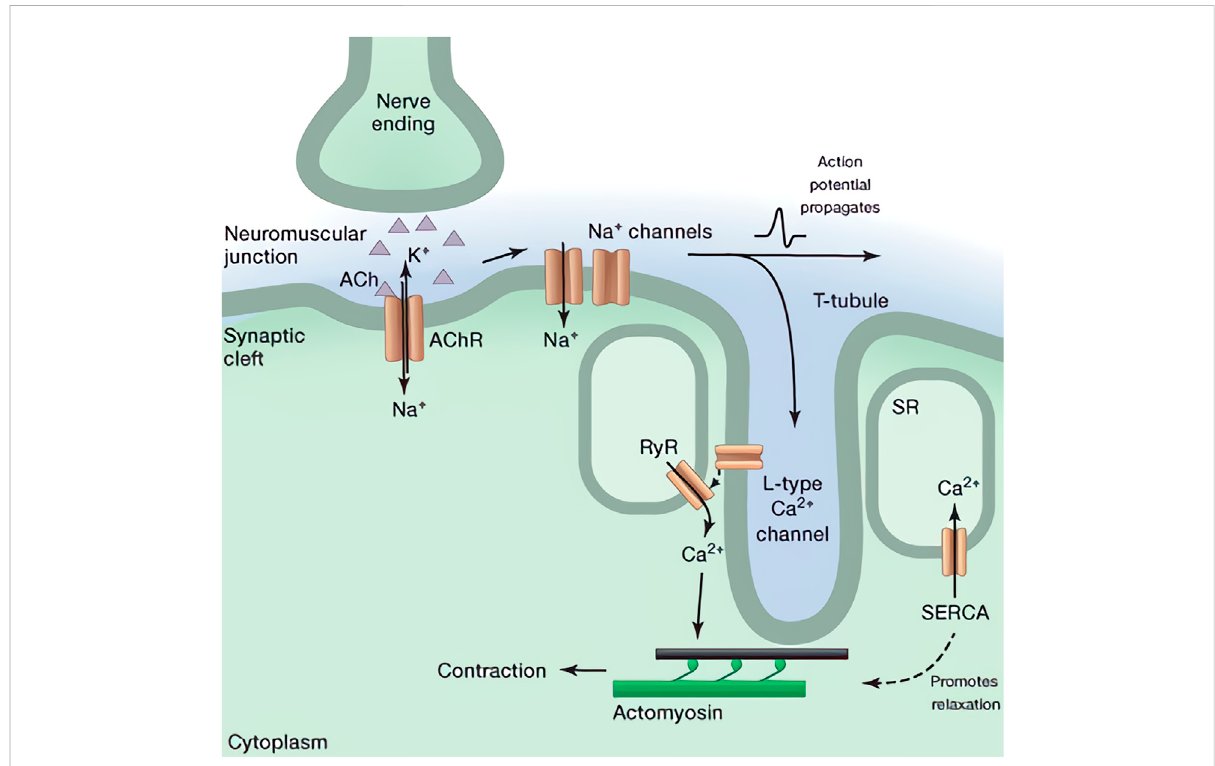
Illustration of force generation in skeletal muscle including signaling pathway and DICR (Kuo and Ehrlich, 2015).